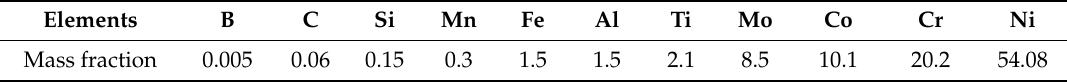
Table 1. Composition of HY282 alloy wt.%.